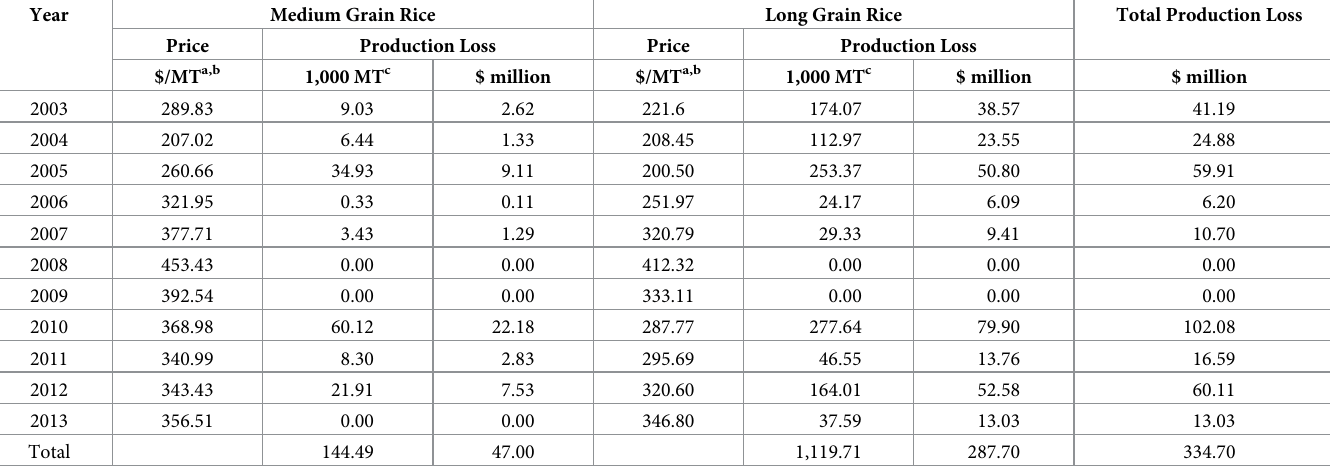
Table 2. Estimated total losses from bacterial panicle occurrences in the Lower Mississippi Delta Region: 2003–2013.